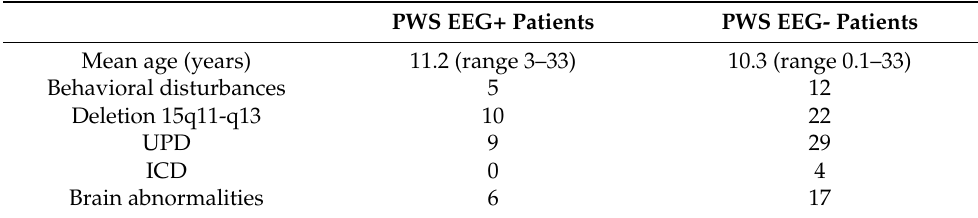
Table 4. Phenotype and genotype characteristics of PWS patients with or without EEG paroxysmal